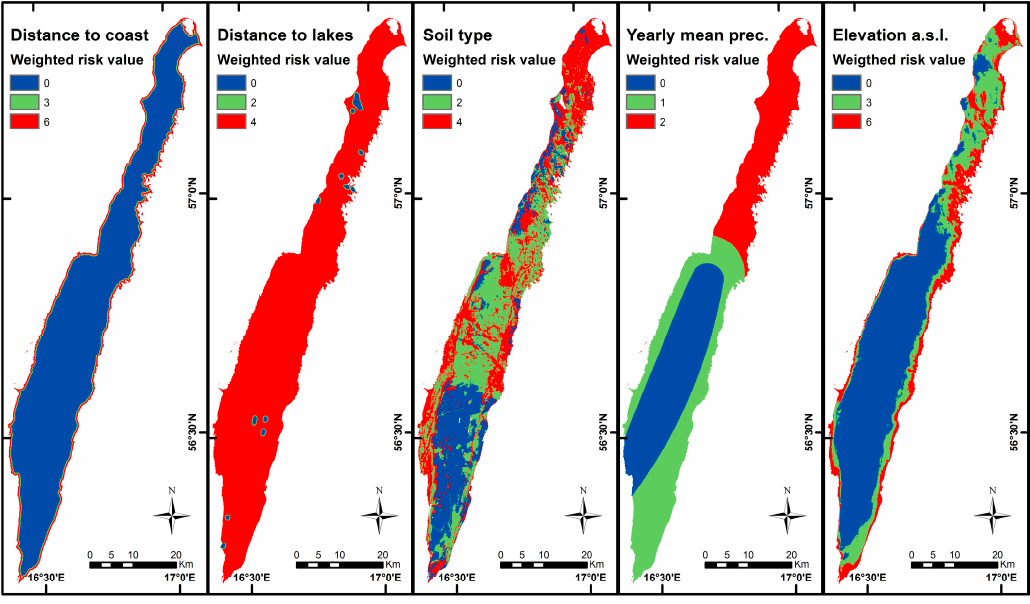
Figure 5. The spatial distribution of the weighted risk value for each parameter used in the risk analysis of saltwater intrusion. These five visualizations are used as a foundation for the final risk map (Figure 6). The weighted risk values and other values are presented in Table